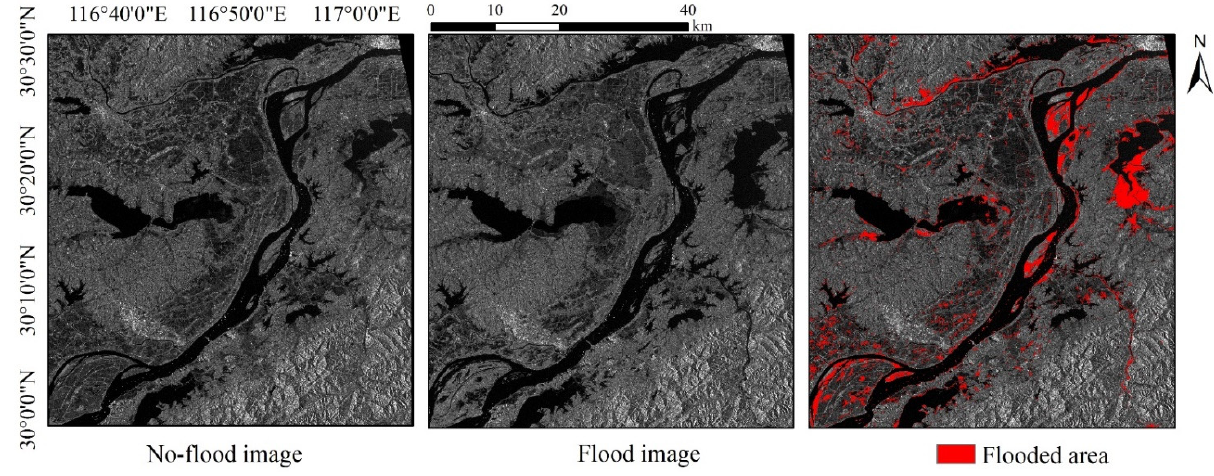
Figure A2. Flood detected in the middle reaches of the Yang tz e River in 2020.